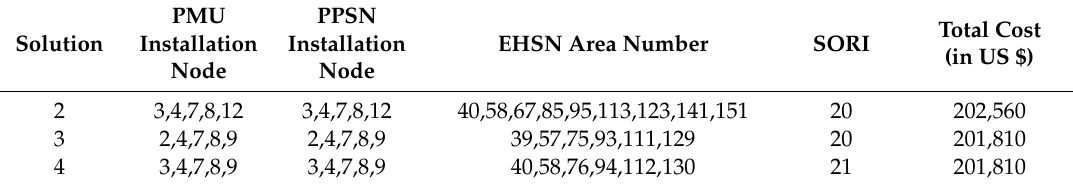
Table 5. Optimization problem result (zero-injection effect).